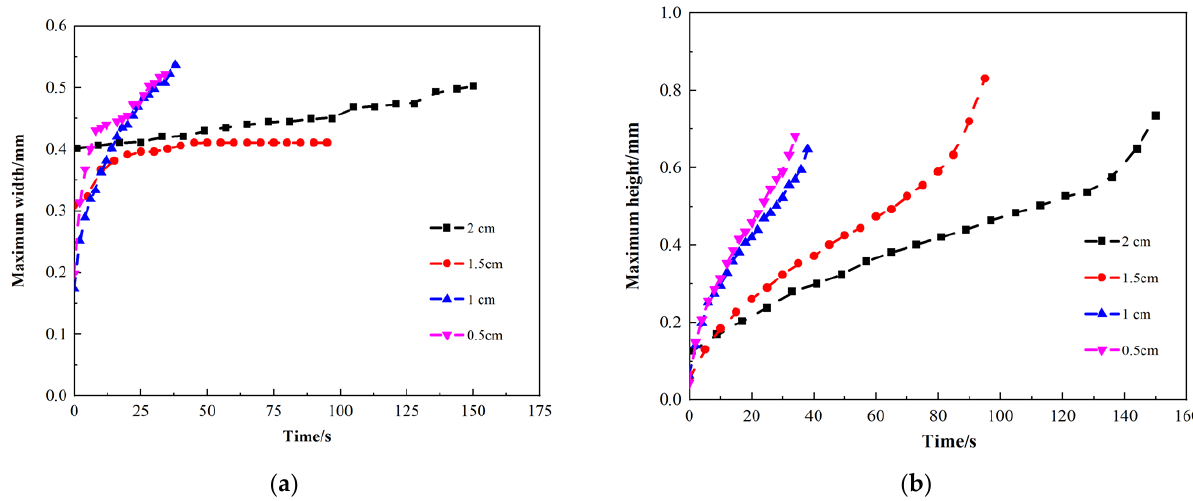
Figure 9. Change of oil drop size of different chip thickness. ( a ) Comparison of maximum width of oil drop; ( b ) Comparison of maximum height of oil drop.